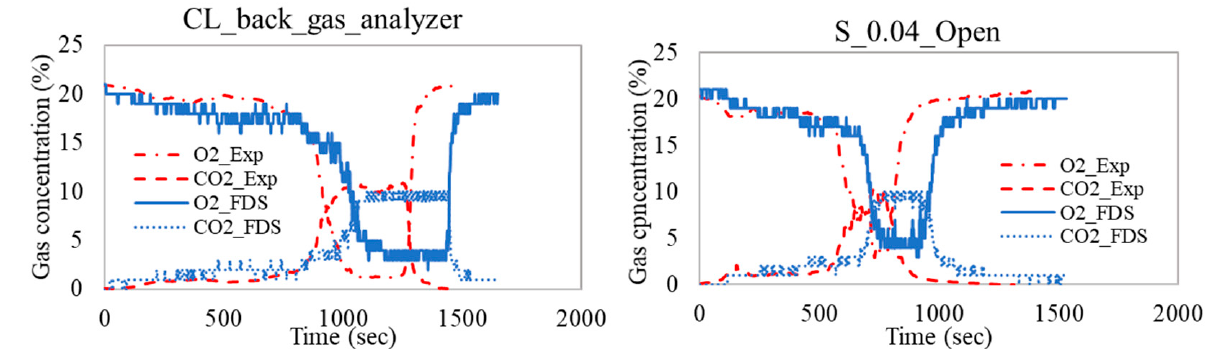
Figure 16. Gas concentration at the back of the compartment for the closed and S_0.04_Open cases.